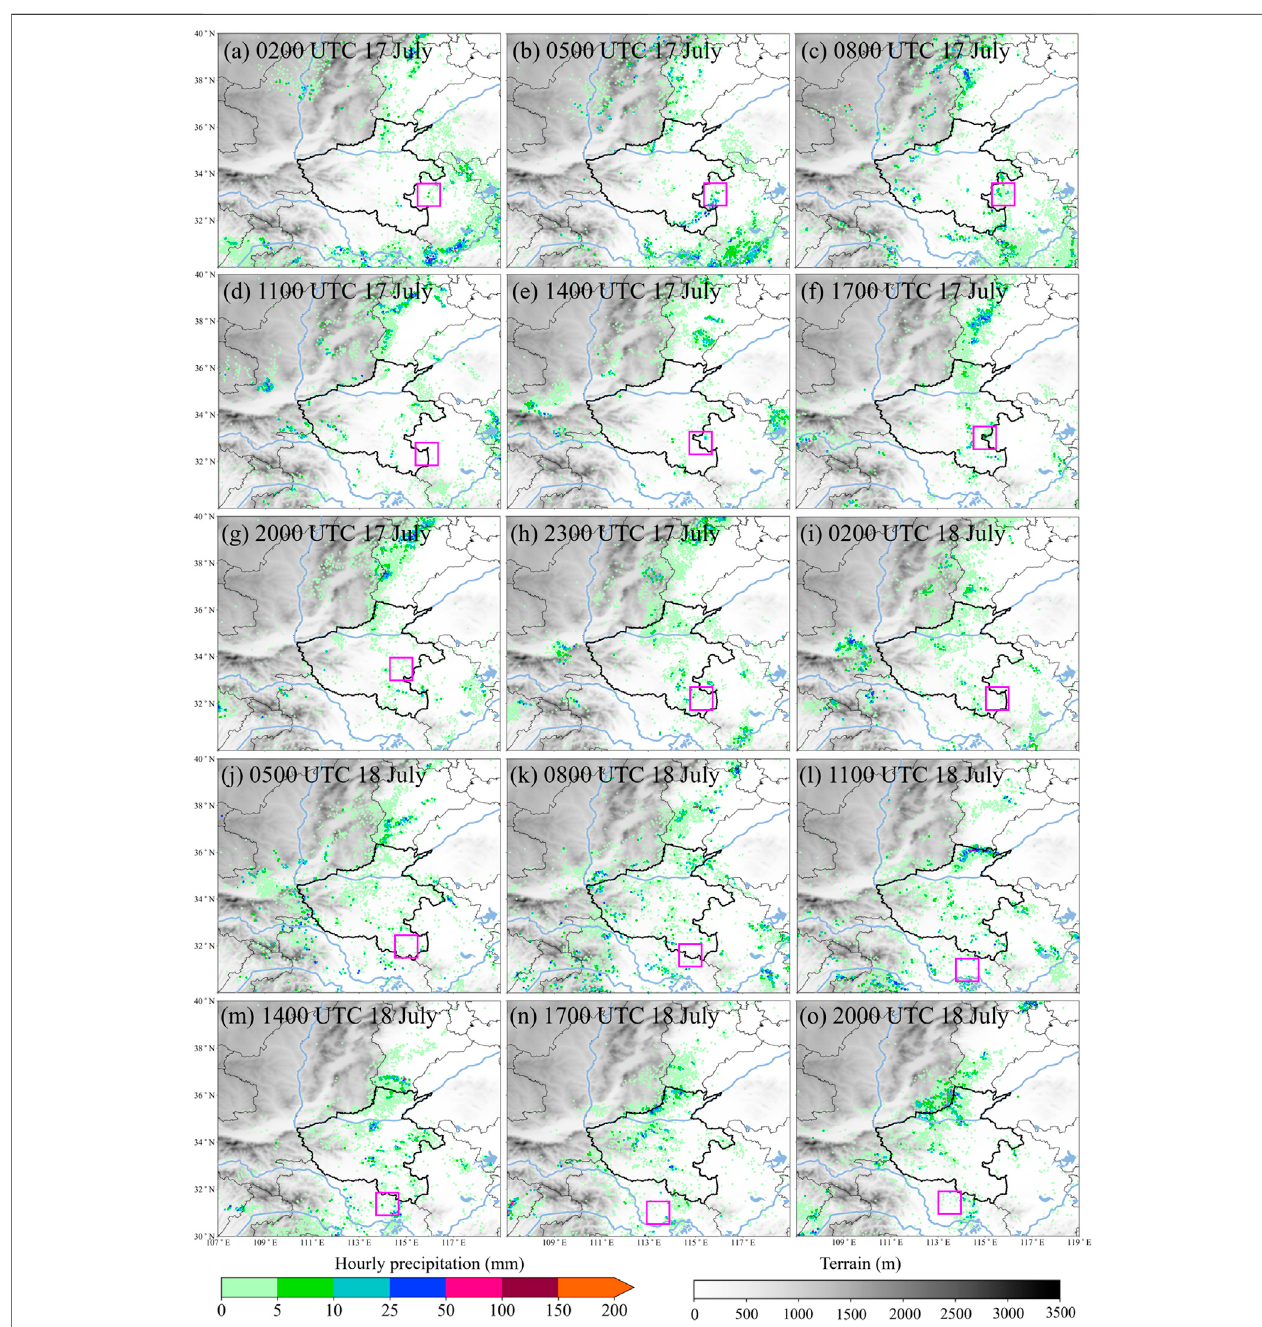
FIGURE 6 | Hourly precipitation (shading dots; mm) within/around Henan during the early stage of the “ 21.7 ” TRE, where shading is terrain and the small purple boxes mark the mesoscale vortex ’ s center.